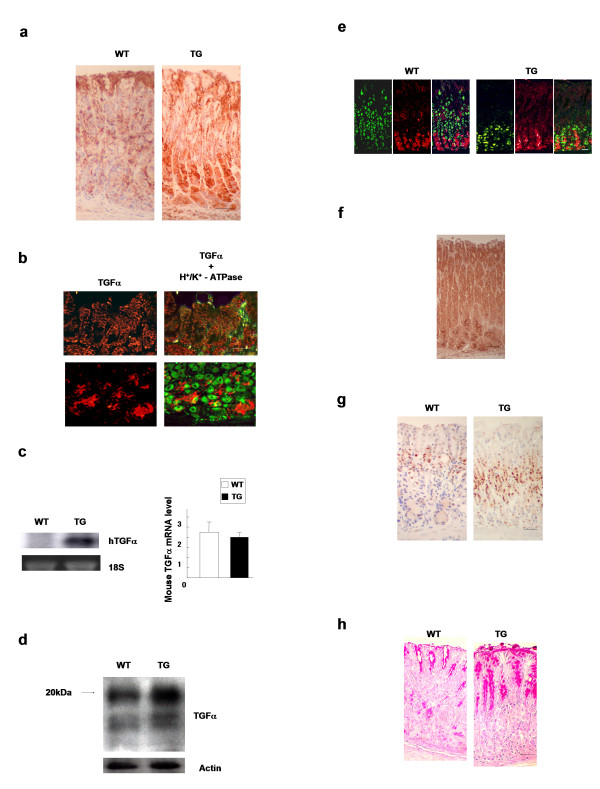
Characterization of the TGFα-expressing TG mucosa. Scale in each figure indicates 100 μm. (a) Distribution of TGFα-expressing cells. Brown-colored TGFα-positive cells were visible along the luminal pit region in the WT mucosa, the elongated foveolar pit region, and the lower one-third of the glandular region in the TG mucosa. (b) Overlap of red-colored TGFα-positive cells and green-colored H+/K+-ATPase-positive parietal cells. Lower TGFα-positive cells in cluster are distinct from the green-colored parietal cells in the TG mucosa. (c) Northern blot of human TGFα mRNA and PCR-amplified mouse TGFα mRNA. Human TGFα mRNA is expressed in the TG mucosa alone (left panel), but PCR-amplified mouse TGFα mRNA is expressed similarly in both WT and TG mucosae (right panel). (d) Western blot of TGFα intermediate forms. TGFα precursor (20 kDa) and its intermediate forms are visualized more intensively in the TG mucosa than in the WT mucosa. (e) Localization of EGF receptor in the gastric mucosa. EGF receptor (EGF-R) was stained with Cy3 (red) and H+/K+-ATPase was stained with FITC (green). EGF-R was immunostained moderately in the upper pit region and strongly in the lower glandular region similarly in both the WT and TG mucosae. (f) Distribution of metallothionein in the gastric mucosa. Metallothionein is immunostained strongly in the lower glandular region, and moderately along the foveolar region. (g) Elongation of the gastric pit of the TG mucosa. PCNA-positive cells are distributed at the upper-third region in the WT gastric glands, whereas they are distributed more numerously and broadly in the middle glandular region. (h) PAS staining shows elongated pit in the TG mucosa.